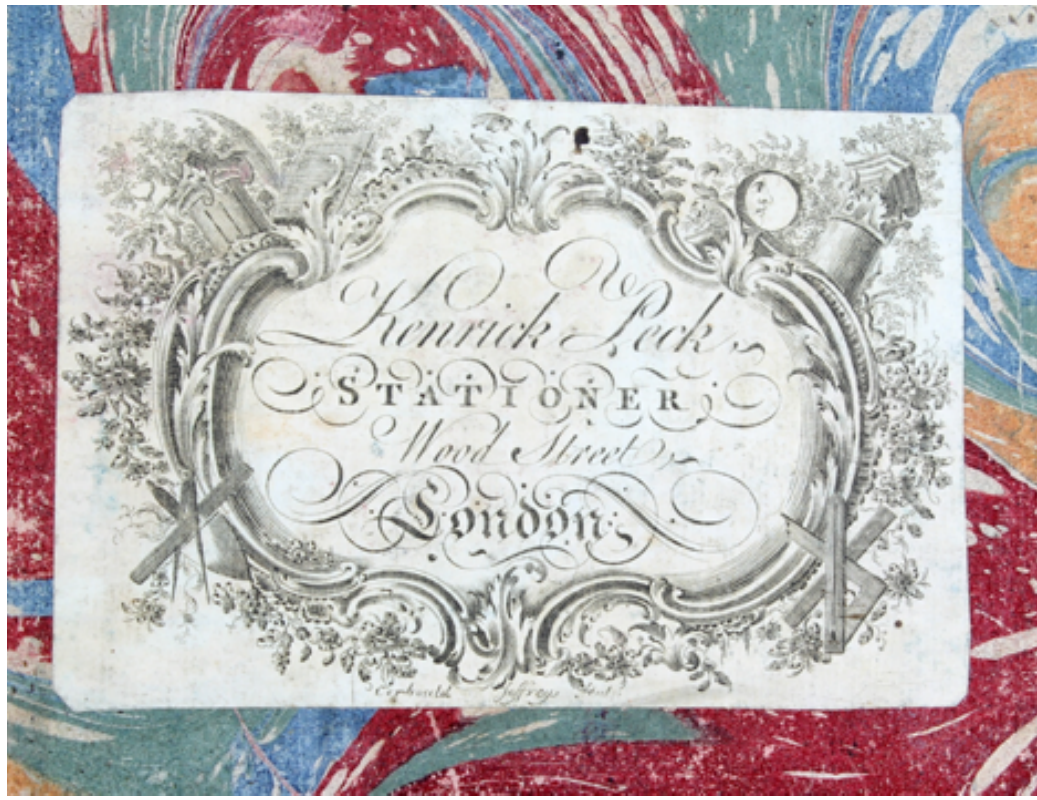
Fig. 21. Peck’s business ticket engraved with masonic motifs. Copyright and reproduced by permission of the Museum of Freemasonry, London.